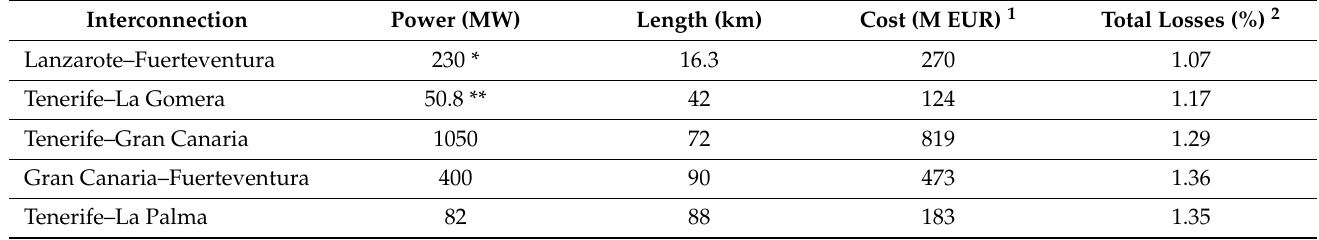
Table 2. Major characteristics of the interconnection system.